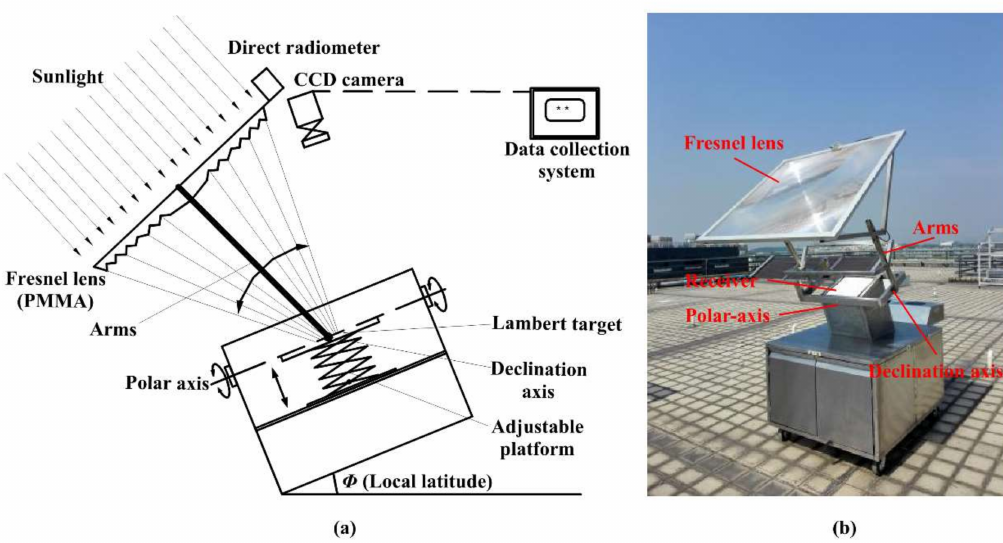
Figure 2. ( a ) Schematic diagram of the experiment platform; and ( b ) a photo of the fixed-focus Fresnel lens solar concentrator using polar-axis